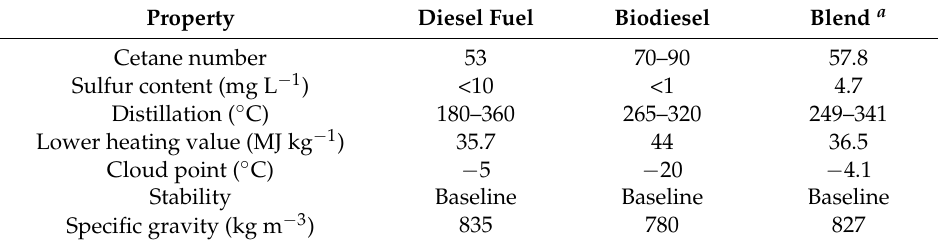
Table 4. Properties of different diesel-like fuels obtained through several